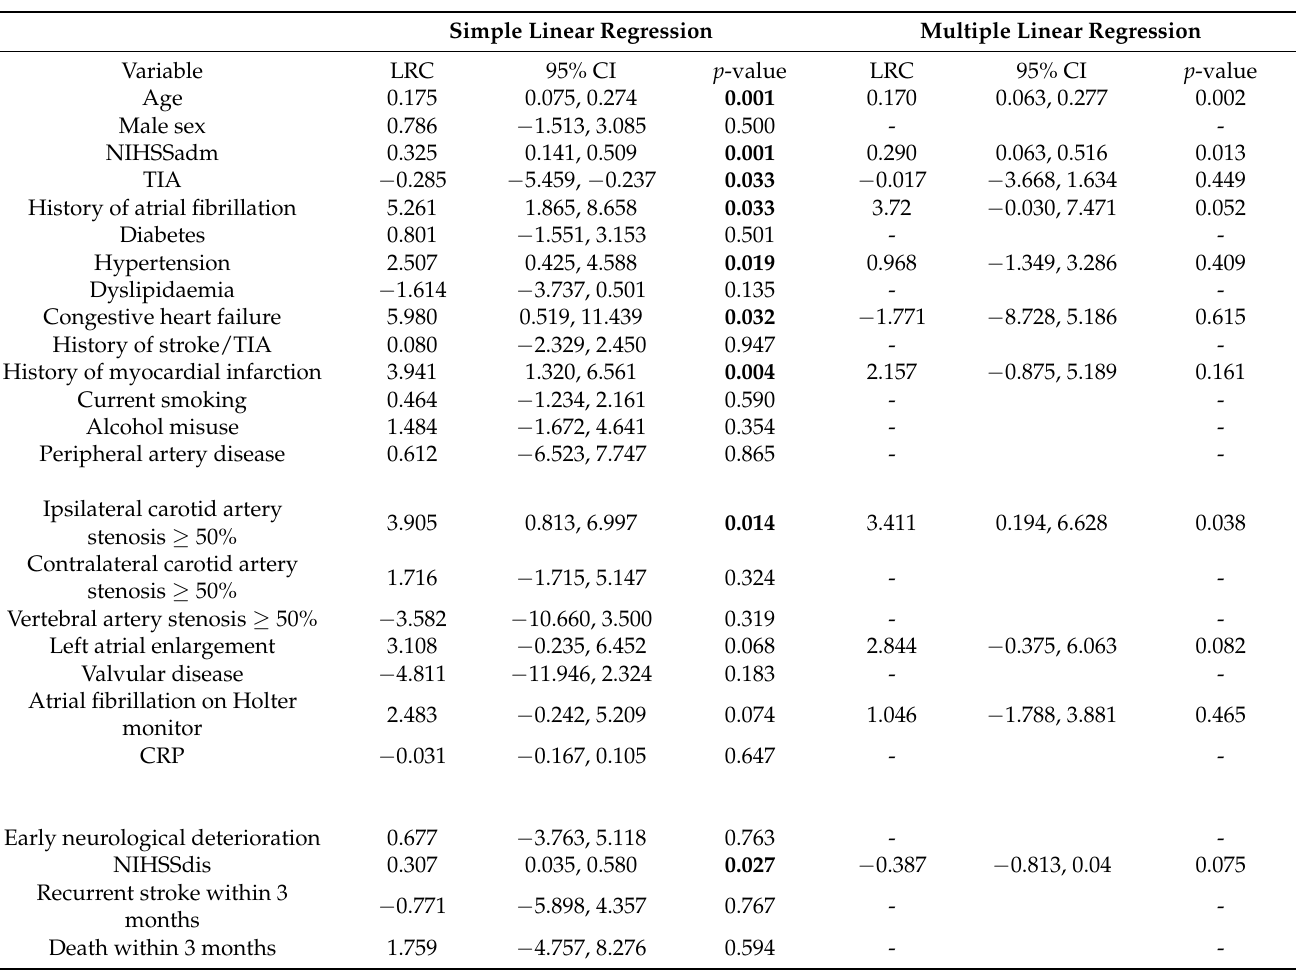
Table 2. Simple and multiple linear regression analyses on the associations of omentin levels with baseline characteristics, neuroimaging findings and outcomes in ACI patients.